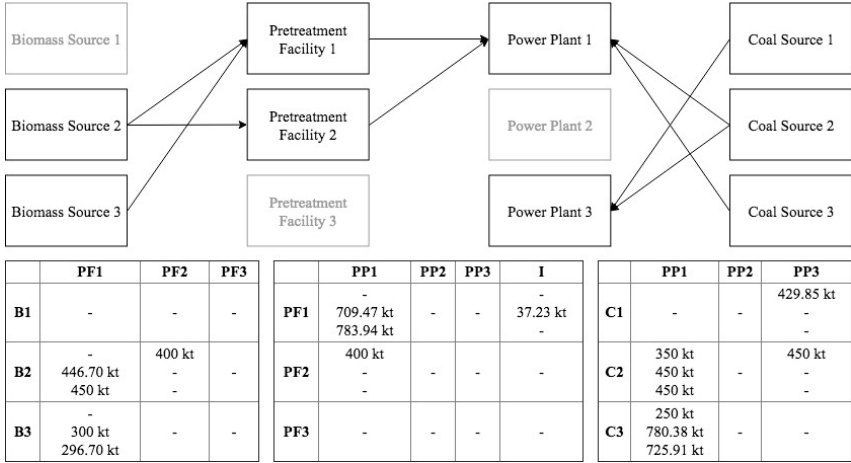
Energies 2019 , 12 , x FOR PEER REVIEW Figure 7. Optimal Biomass Co-firing Network without Quality Considerations. Figure 7. Optimal Biomass Co-firing Network without Quality Considerations.